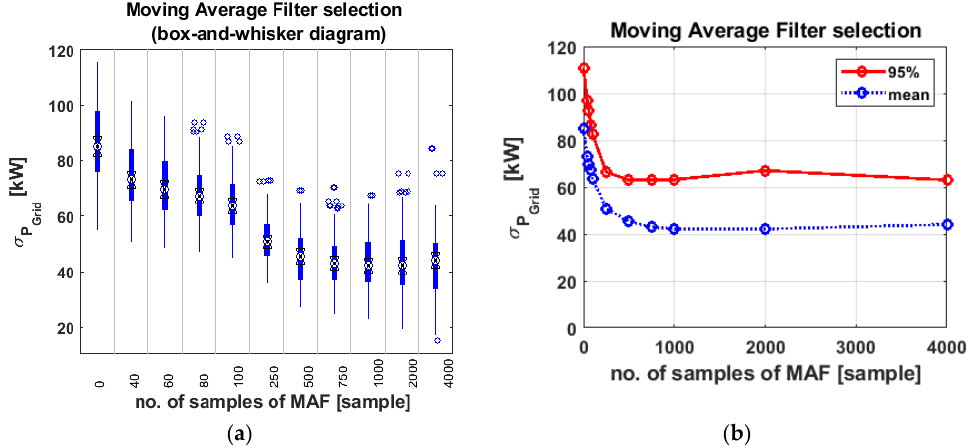
Figure 11. ( a ) Box and whisker diagram: standard deviation of the power generated by the WEC plant as a function of the number of MAF samples; ( b ) Standard deviation change in two cases: the average value and a value including 95% of the cases in each analysis, both as a function of the number of MAF samples.